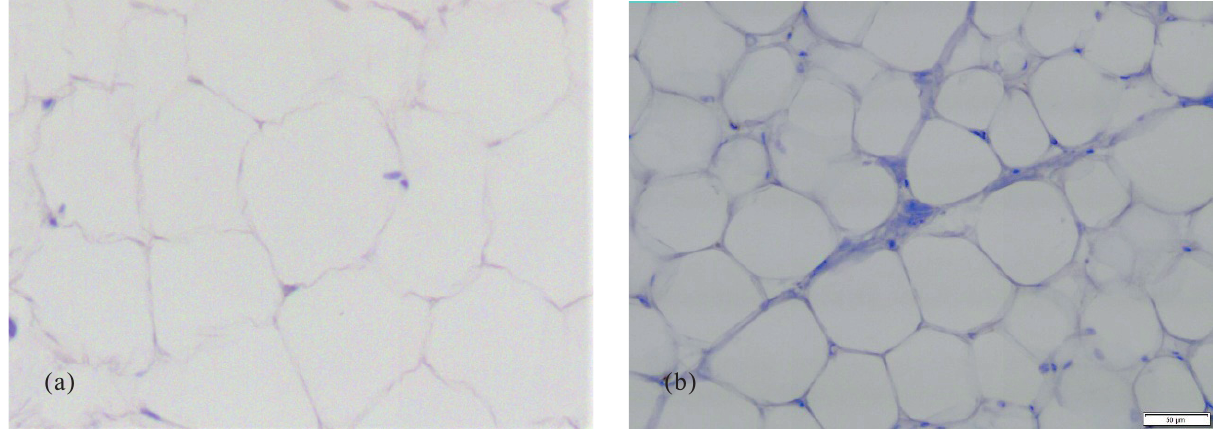
Fig. 1. Normal white adipose tissue in control group: (a) subcutaneous white adipose tissue (20×), (b) visceral white adipose tissue (20×). No macrophages. Immunohistochemical staining CD68.